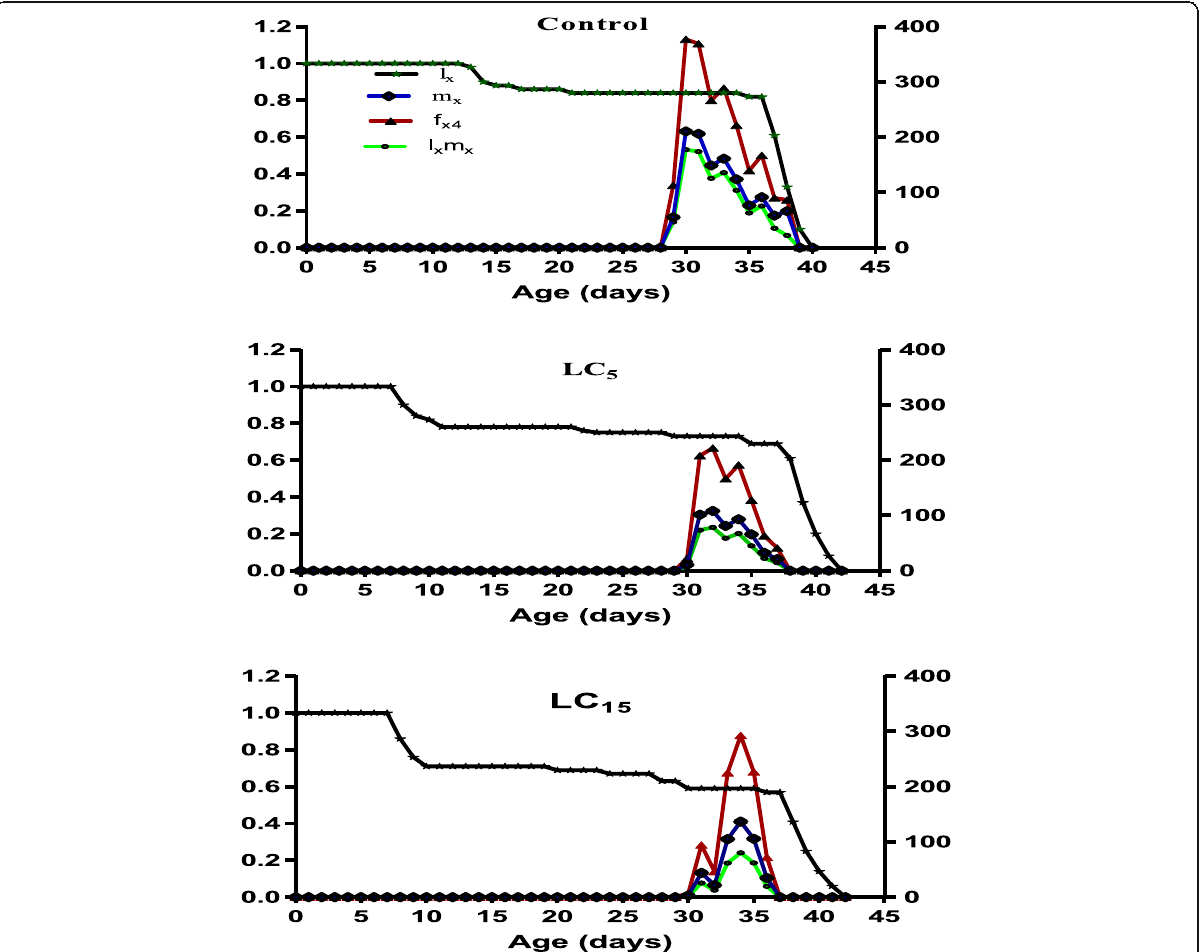
Fig. 3 Age-specific survival rate ( l x ), female age-specific fecundity ( f x4 ), age-specific fecundity of the total population ( m x ), and age-specific maternity ( l x m x ) of S. littoralis exposed to sublethal concentrations of